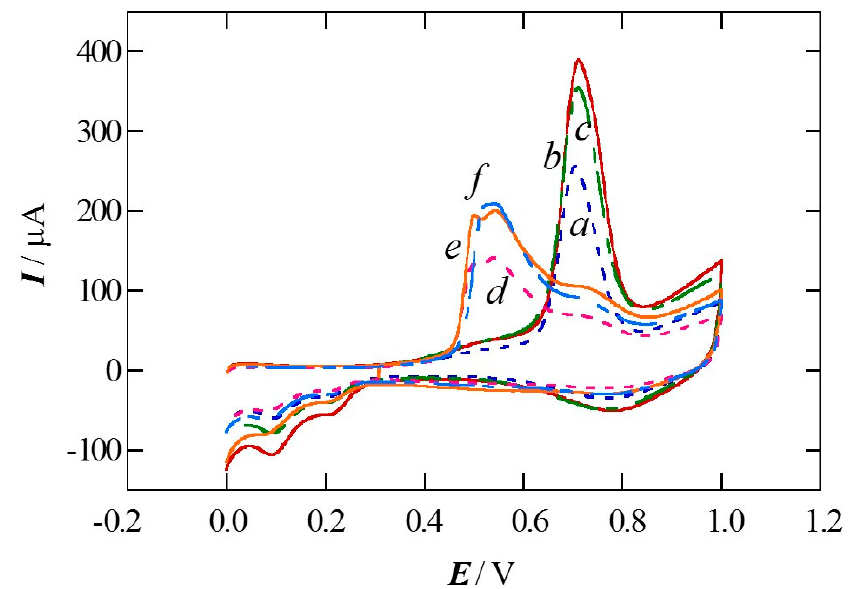
Figure 5. CO stripping curves for the different electrocatalysts recorded after different times of Pt exchange following the synthesis sequence ii : 20 (curves a and d ), 30 (curves b and e ) and 60 min (curves c and f ). Curves a , b and c correspond to Pt(Cu)/C and curves d , e and f , to Pt ‐ Ru(Cu)/C. Sweep rate 20 mV s − 1 .